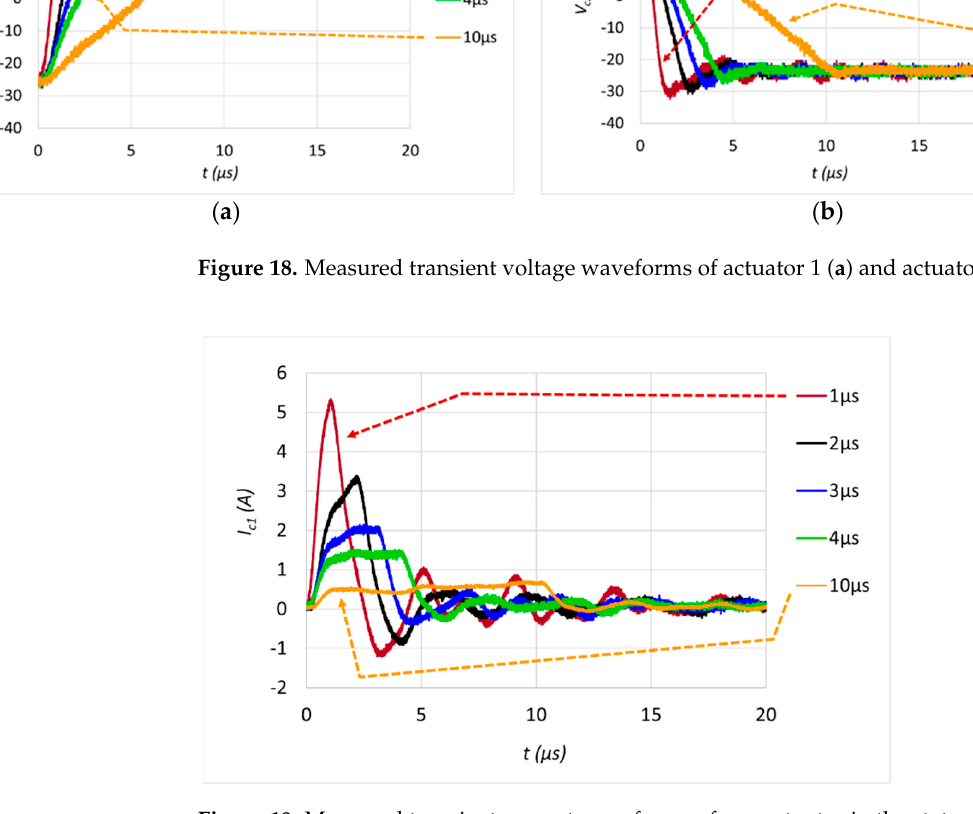
Figure 18. Measured transient voltage waveforms of actuator 1 ( a ) and actuator 2 ( b ).